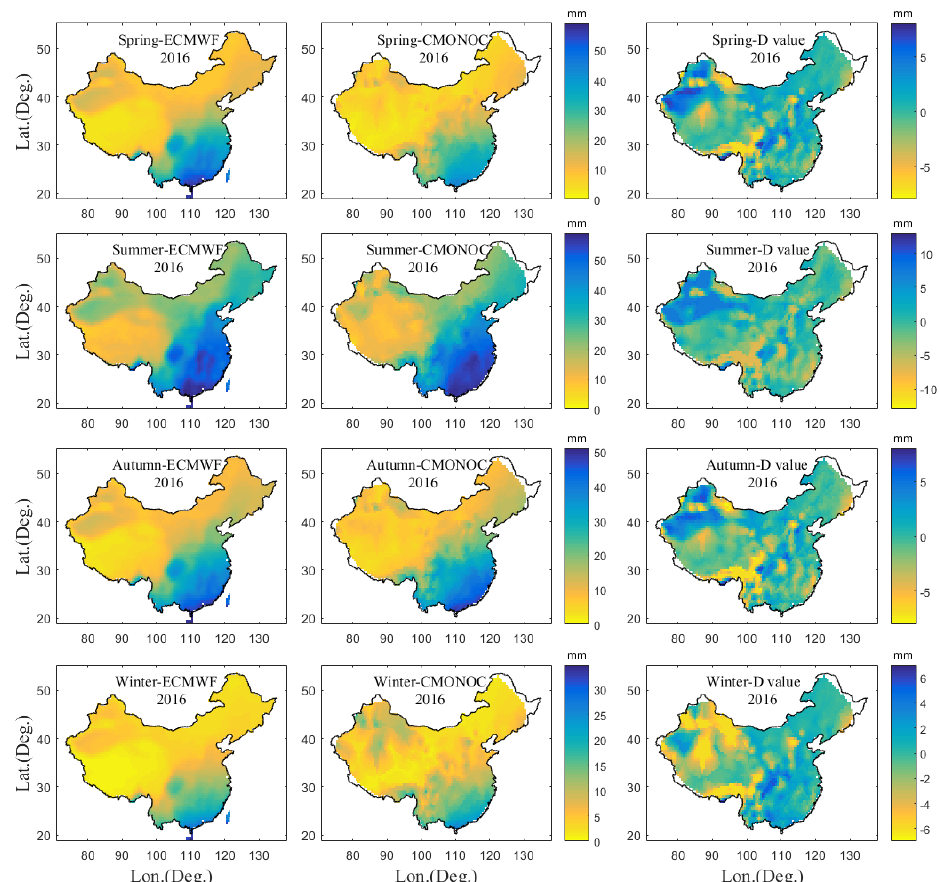
Figure 10. Mean PWV image derived from GNSS and ERA5 in different seasons and their difference distributions in 2016.